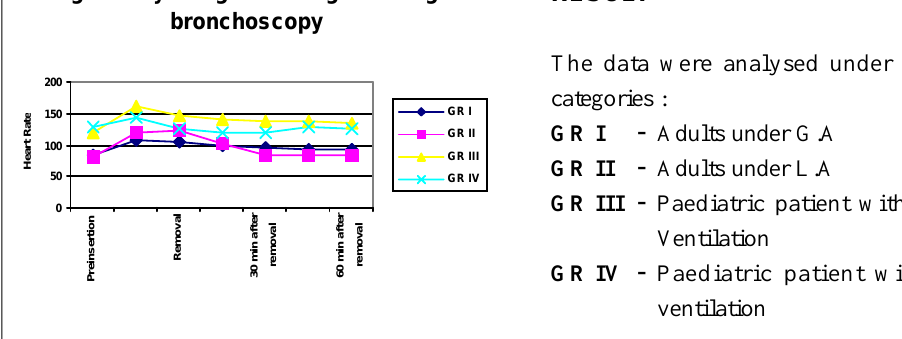
Fig. 2 : Physiological Changes during bronchoscopy